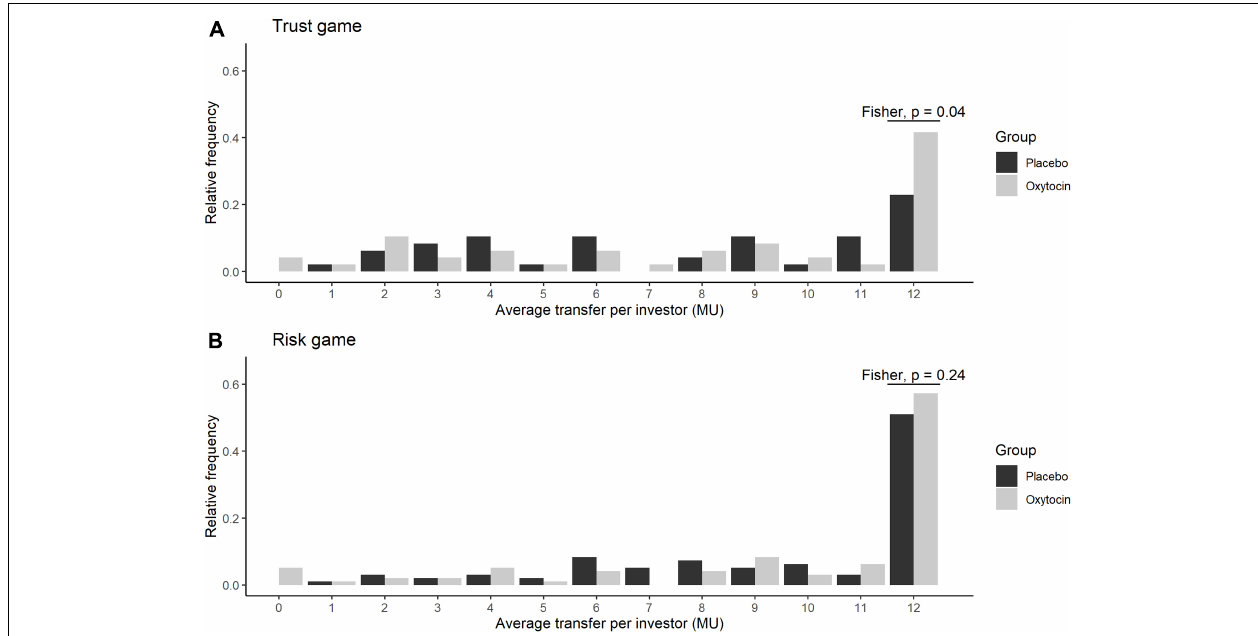
FIGURE 2 | Relative frequency of the average transfers in the oxytocin and placebo groups. The x axis represents the average transfer per investor. For instance, if the average transfer per investor equals 12, it means that the investor sent the maximum amount of MU in all four rounds. The y axis represents the relative frequencies of investors for each average transfer. Black and white bars represent the relative frequency of the average transfers in the placebo and oxytocin groups, respectively. Participants who received oxytocin demonstrated a greater degree of trust than those who received placebo. In the trust experiment (A) , 20 of 48 participants in the oxytocin group transferred the maximum amount (12 MU), whereas only 11 of 48 participants in the placebo group did the same (Fisher’s exact test; P = 0.04; one-sided). In the risk experiment (B) , we did not observe a significant difference in this behavior between the groups (Fisher’s exact test; P = 0.24;